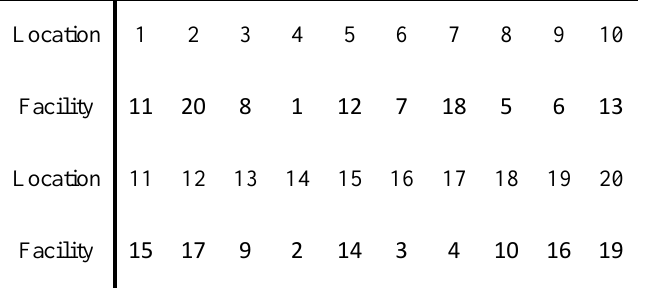
Table 3. Optimal layout by DSA method